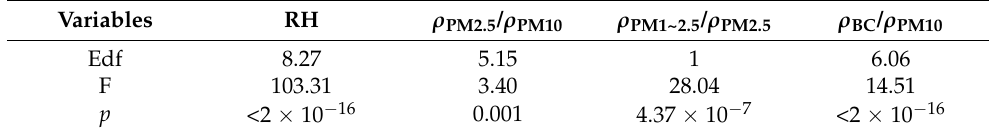
Table 6. Simulation results by the GAMs with multi-influencing factors at PM 2.5 pollution concentration. Variables